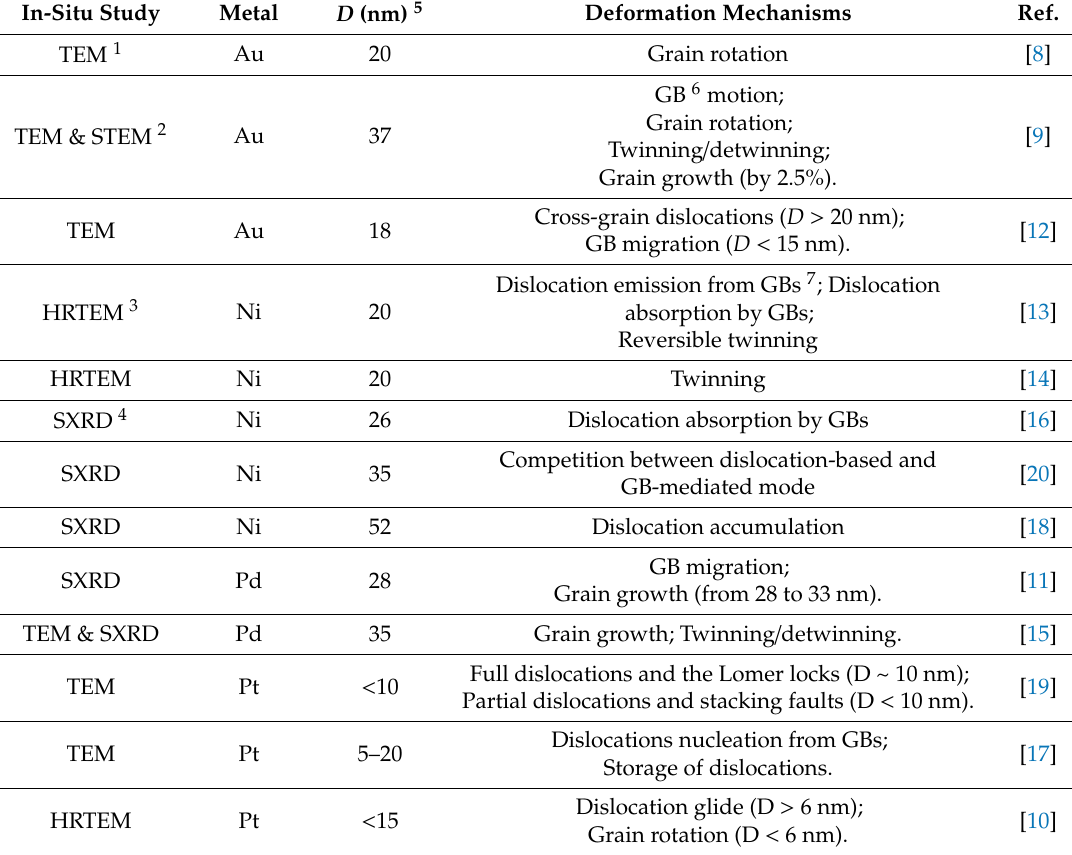
Table 1. In situ studies and deformation mechanisms for nc Au, Ni, Pd and Pt